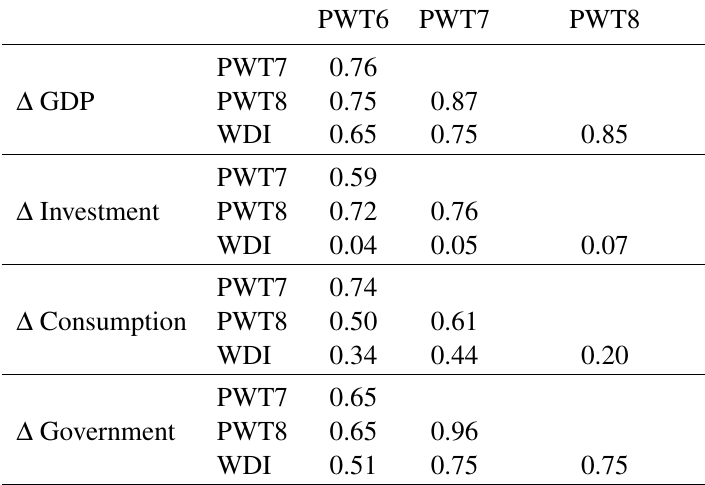
Table 1: Correlations between growth rates of the core